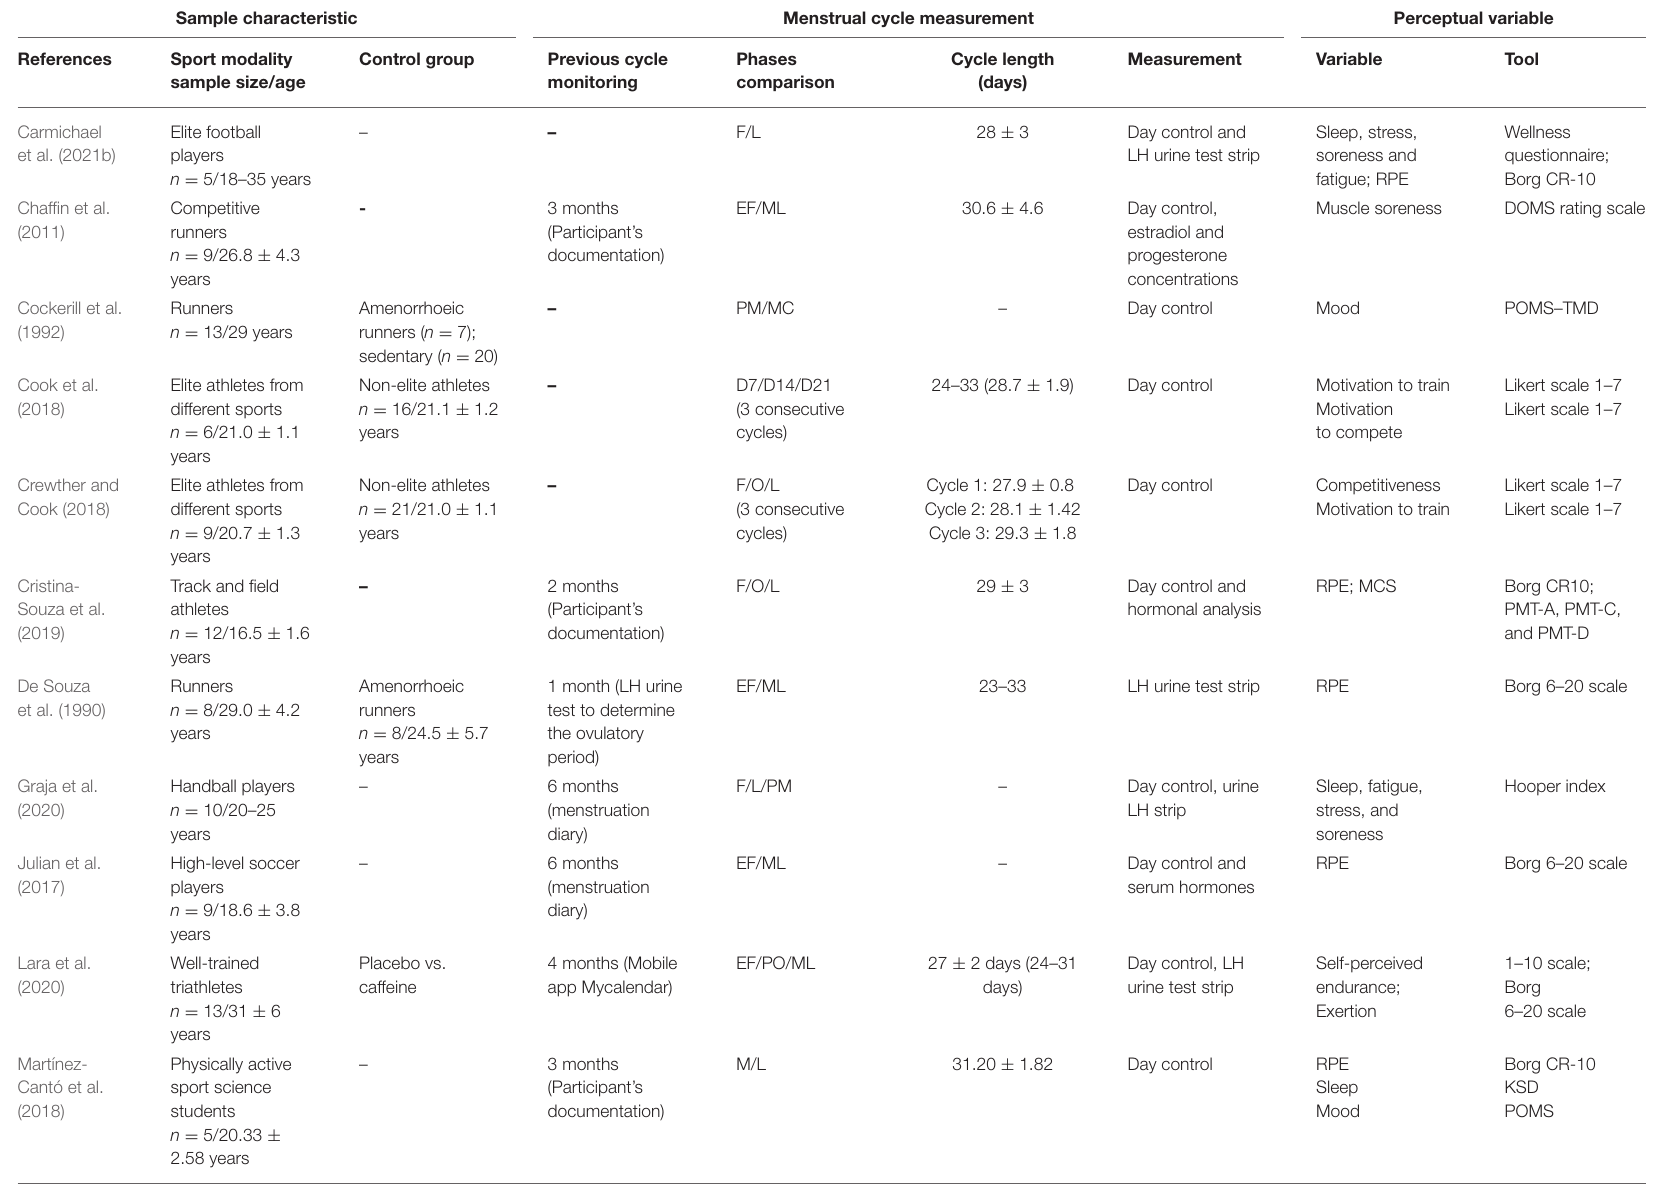
TABLE 1 | Sample characteristics, menstrual cycle measurement and perceptual